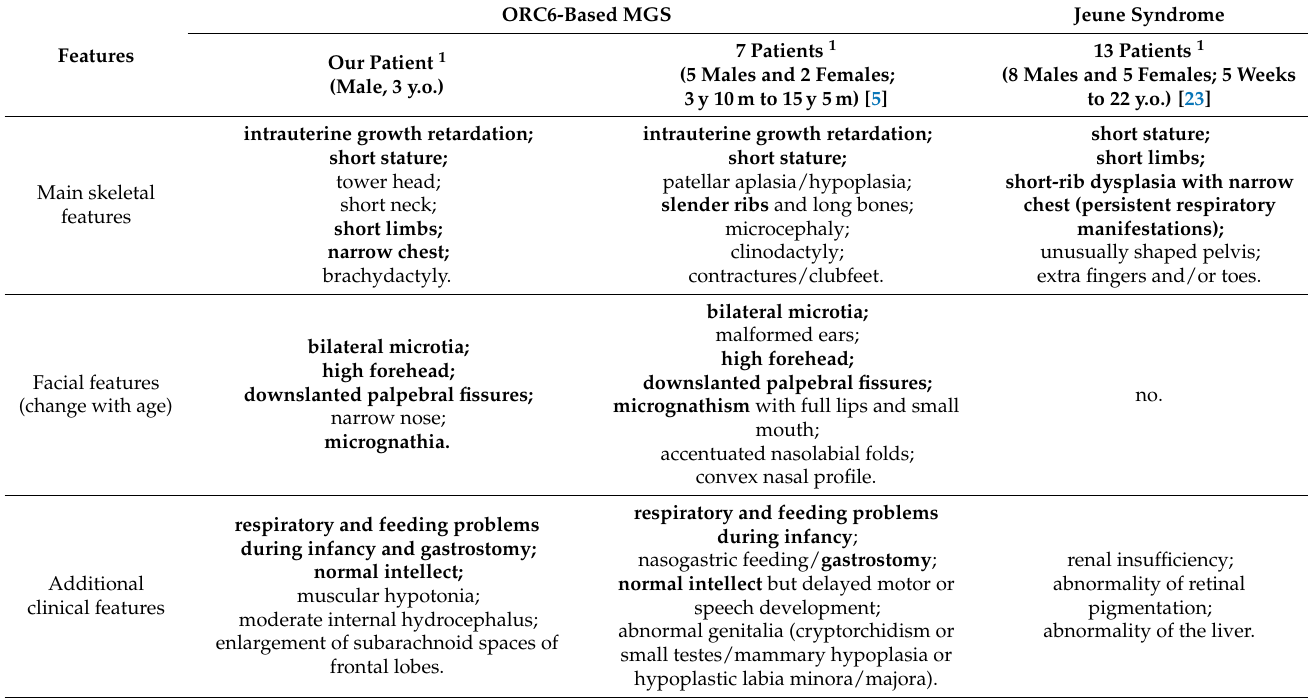
Table 2. Possible symptoms of ORC6-based MGS and Jeune